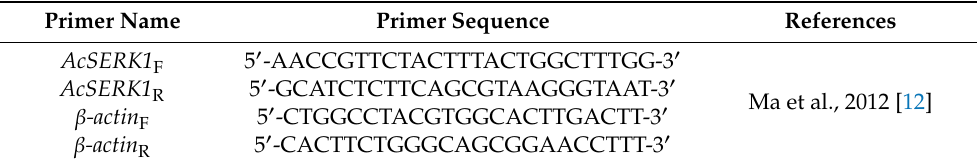
Table 1. Primers used for quantitative real-time PCR